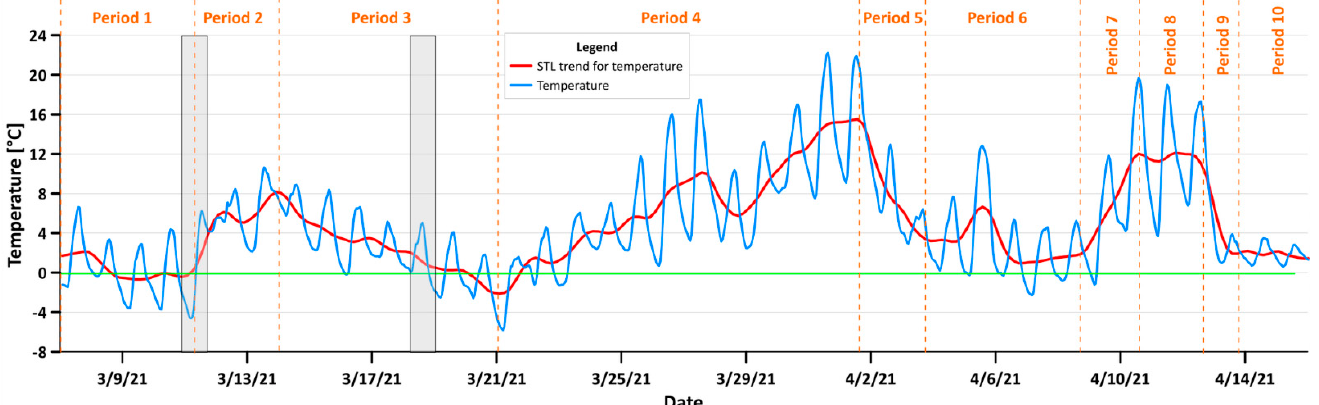
Figure 4. The temperature in Krakow between the 7th of March and 16th April (blue) and the temperature STL trend (red). The green line indicates zero Celsius degree point; grey boxes are days chosen for the inflow and outflow study. Orange marks represent 10 different temperature periods.